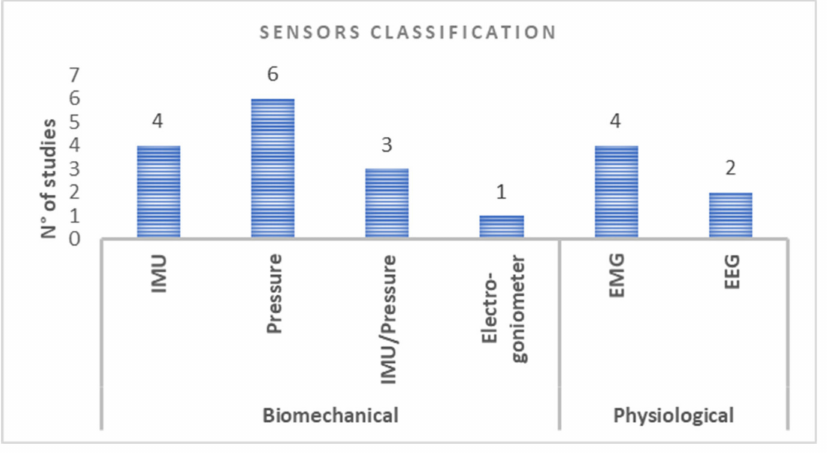
Figure 2. Classification of sensors used in the included studies: biomechanical (IMU, pressure and electrogoniometer) and physiological (EMG and